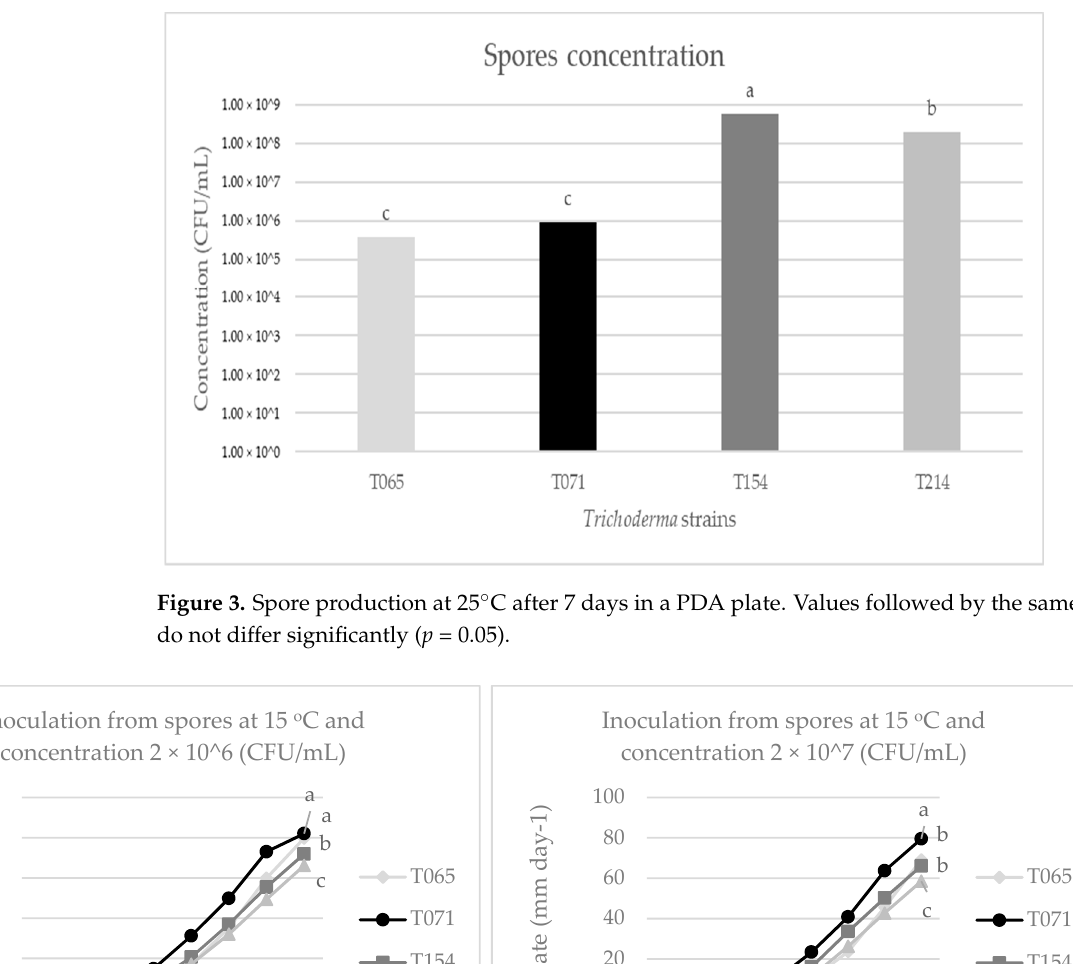
Figure 3. Spore production at 25°C after 7 days in a PDA plate. Values followed by the same letter do not differ significantly ( p = 0.05).